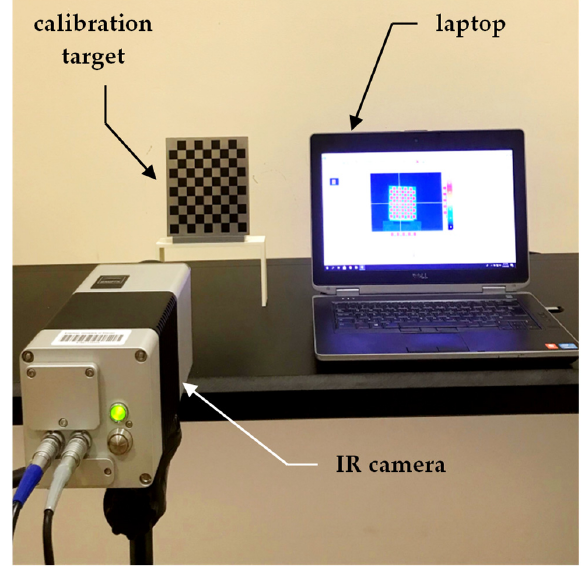
Figure 5. A presentation of the experimental setup used in this study.